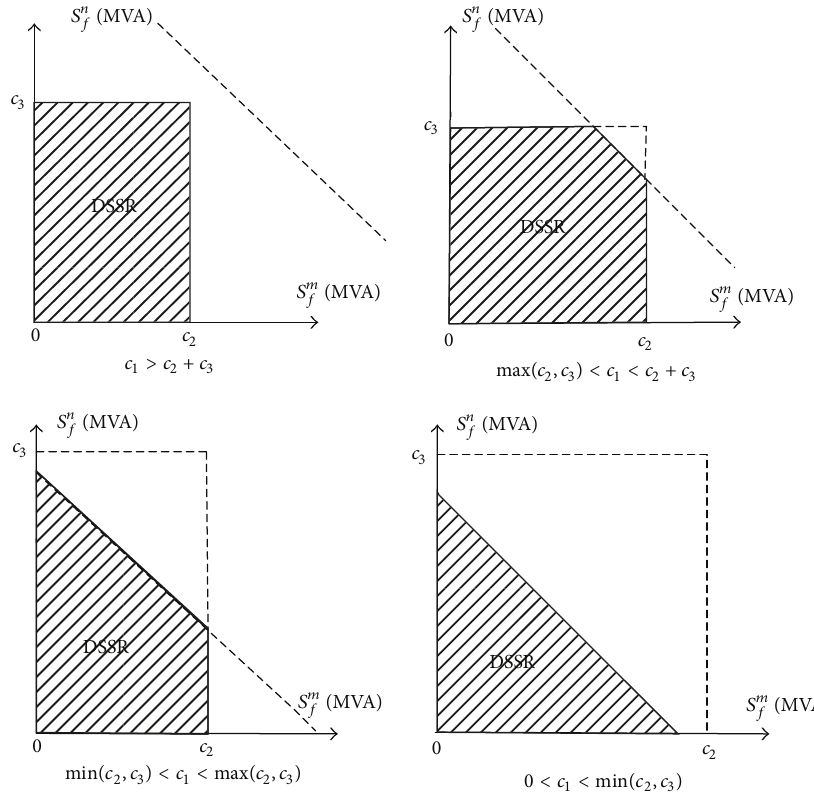
Figure 3: Shapes of 2-dimension cross-section of